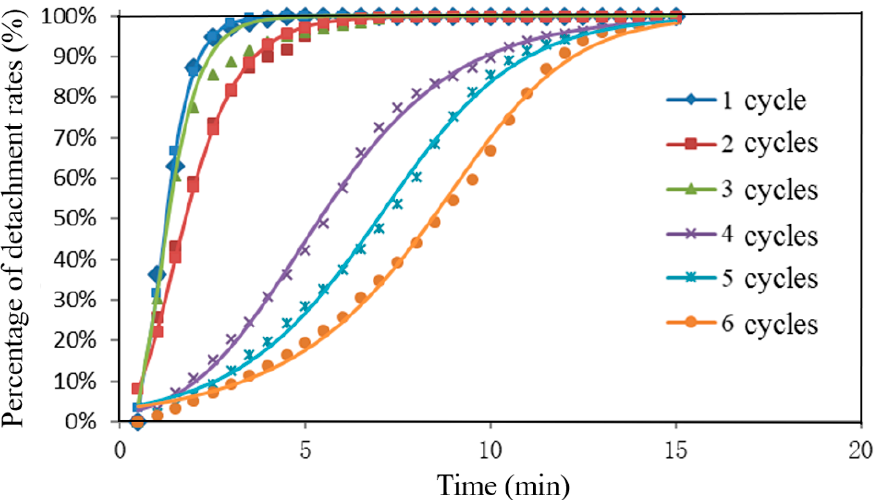
Figure 5. S-curve comparisons of soil detachment data collected with time from the laboratory runoff experiment to the fitted curves as the influence of soil wetting and drying. Table 1. Richards model parameters (cumulative sediment loss value ( K ), the initial sediment loss value ( a ), the rate of change ( b ), and the allometric parameter ( c )) used for predicting the soil detach- ment rate as affected by wet-dry cycles and their corresponding correlation and residual values.